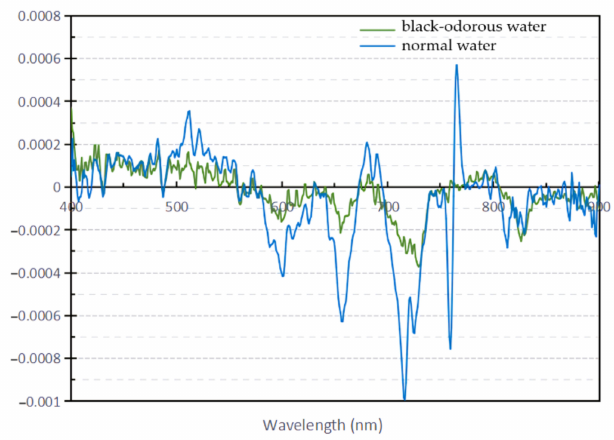
Figure 4. Comparison of the first derivative between the average spectrum of black-odorous water and the average spectrum of normal